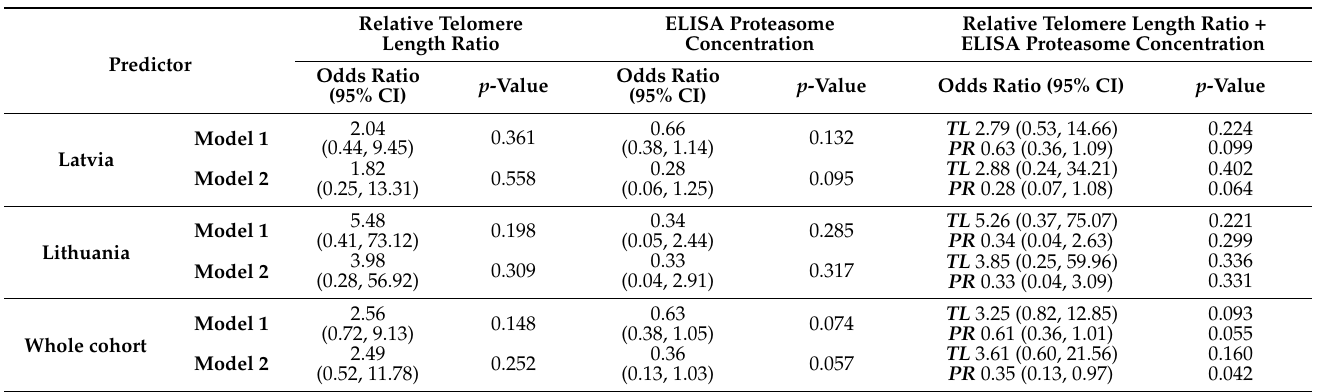
Table 5. Association between severe retinopathy, telomeres and proteasomes on a country-by-country basis and in the whole